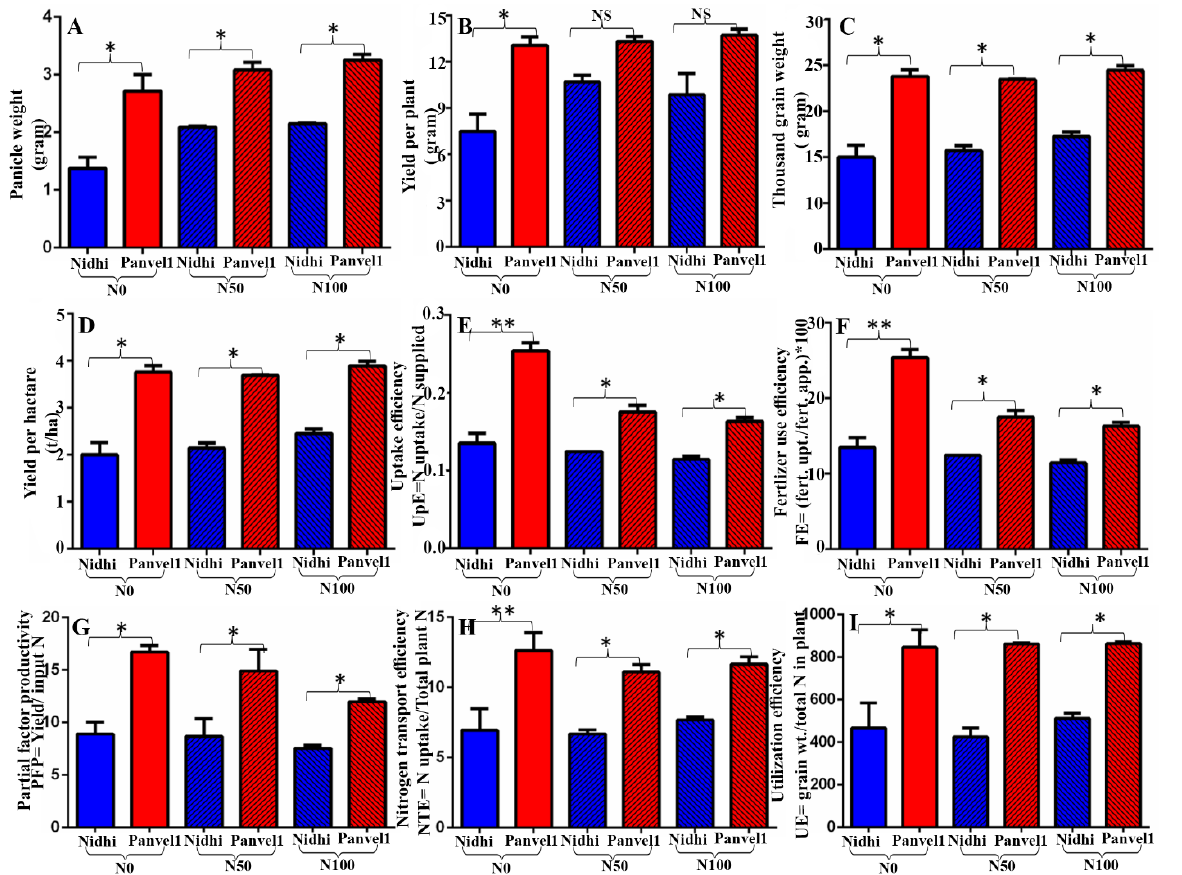
Figure 5. Field validation of the performance of rice genotypes. Field evaluation of the genotypes Nidhi and Panvel1 was conducted at National Rice Research Institute (NRRI-ICAR) Cuttack, Odisha, India in N0, N50 and N100 N kg of added urea/ha. Mean data of the effect of urea dose on the genotypes are shown for panicle weight, yield per panicle, 1000 grain weight, grain yield per hectare, uptake efficiency, fertilizer use efficiency, partial factor productivity, nitrogen transport efficiency and utilization efficiency. The significance levels are shown between the bars of genotype Nidhi and Panvel1 for each of the urea dose being compared (* p < 0.05, ** p < 0.01 and NS denotes non-significant).